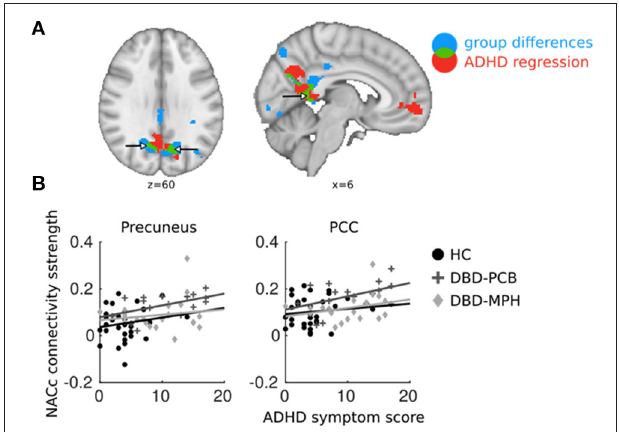
FIGURE 4 | Overlapping regions between ADHD regression and DBD group comparisons. ADHD regression analyses were performed in DBD subjects only. (A) In blue, brain areas of NAcc connectivity significantly different between DBD-PCB and HC groups; in red, NAcc connectivity significantly related to ADHD symptoms; in green, overlap between the two. (B) Average connectivity strength in PCC and precuneus plotted against ADHD symptom scores (to avoid double-dipping, we used the cluster-averages from the DBD-PCB vs. HC comparison). ADHD, Attention deficit/hyperactivity disorder; PCC, Posterior Cingulate Cortex; NAcc, Nucleus Accumbens; HC, Healthy control; PCB, Placebo; MPH, Methylphenidate. x and z coordinates are in MNI space.